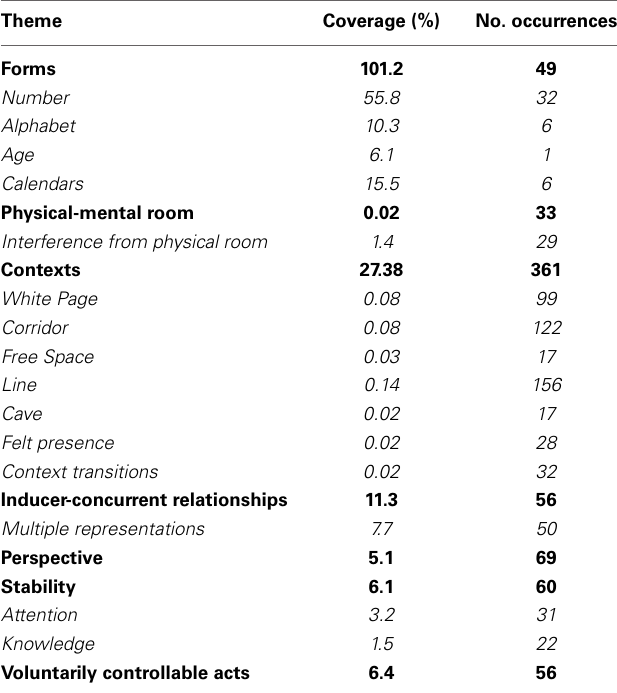
Table 1 | Coding summary